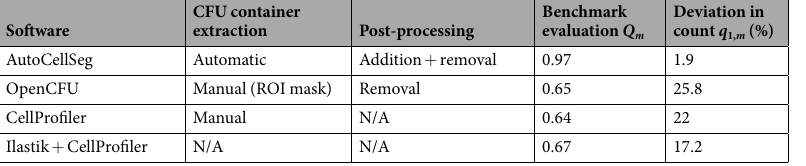
Table 1. Quality comparison of different methods using benchmark images. The Q m and q 1,m values shown in the last two columns are the average values for all 12 images